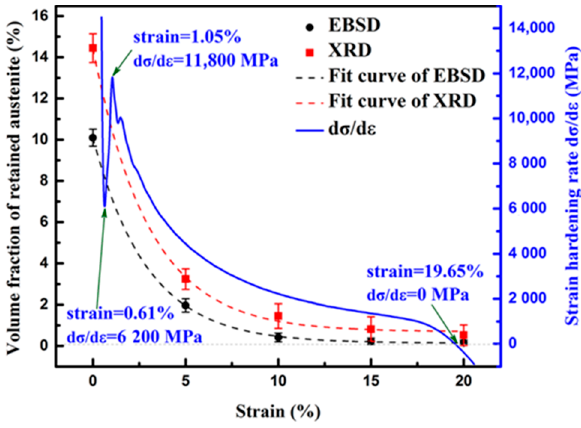
Figure 7. Variation curves of RA volume fraction and strain hardening rate with increasing strain.